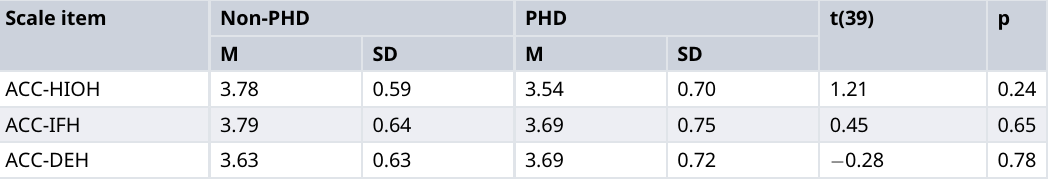
Table 2. Comparisons of mean scores of acceptance of eHealth domains for mental wellness between education-level groups using independent sample t-tests. Scale